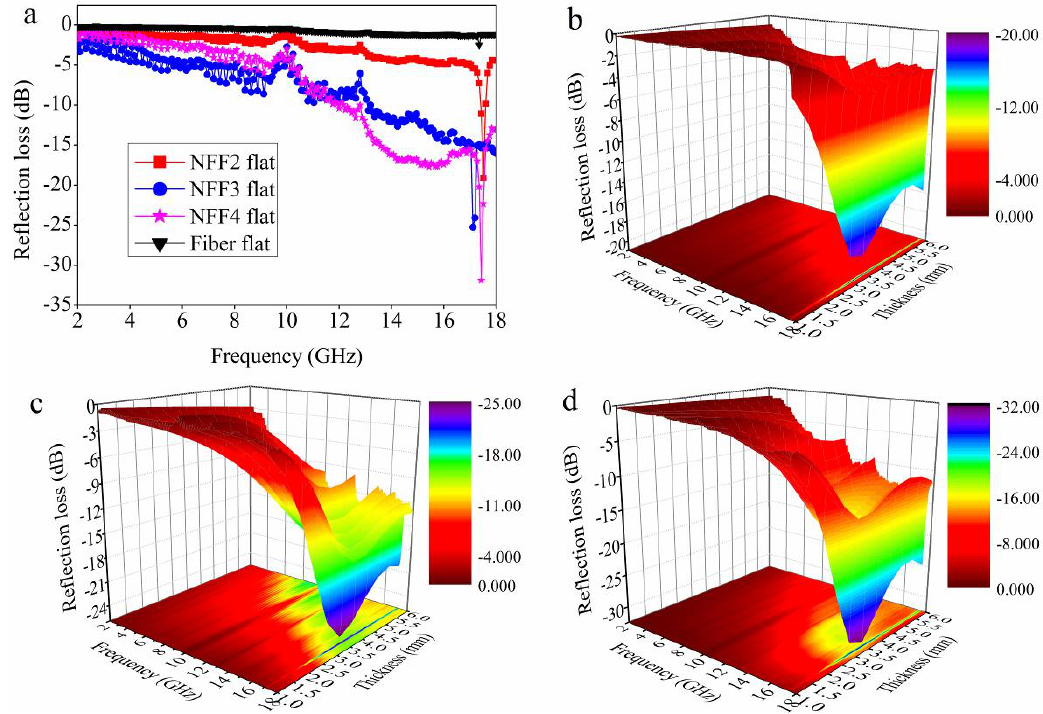
Figure 11. ( a ) Reflection loss curves of NFF composites at a frequency range of 2–18 GHz with a thickness of 3.5 mm; The three-dimensional graph of reflection loss of NFF2 board ( b ); NFF3 board ( c ) and NFF4 board ( d ).